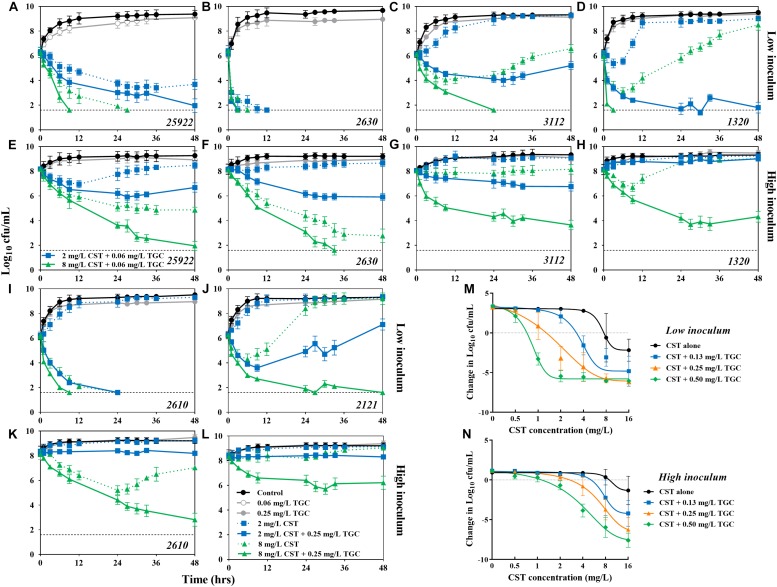
Combinatorial bactericidal activity of colistin and tigecycline against mcr-1-positive and -negative E. coli strains harboring blaNDM–5. (A–L)
In vitro time-kill experiments of colistin (2 and 8 mg/L) alone and in combination with tigecycline (0.25 mg/L) against all study E. coli strains at low and high inoculums over 48 h. The horizontal dotted line represents the limit of detection for bacterial count (40 cfu/mL). Historical time-kill data of colistin alone for potion of strains was obtained from our previous study (Zhou et al., 2017). (M,N) The concentration-effect profiles of colistin against E. coli strains harboring both blaNDM–5 and mcr-1 (i.e., 1320, 2610, and 2121) at low (M) and high (N) inoculums following treatment with colistin (0–16 mg/L) at fixed concentrations of tigecycline (0–0.5 mg/L). Each symbol represents the log10 change in bacterial burdens over a 48 h study period. Data points below the line represent killing and points above the line represent growth.